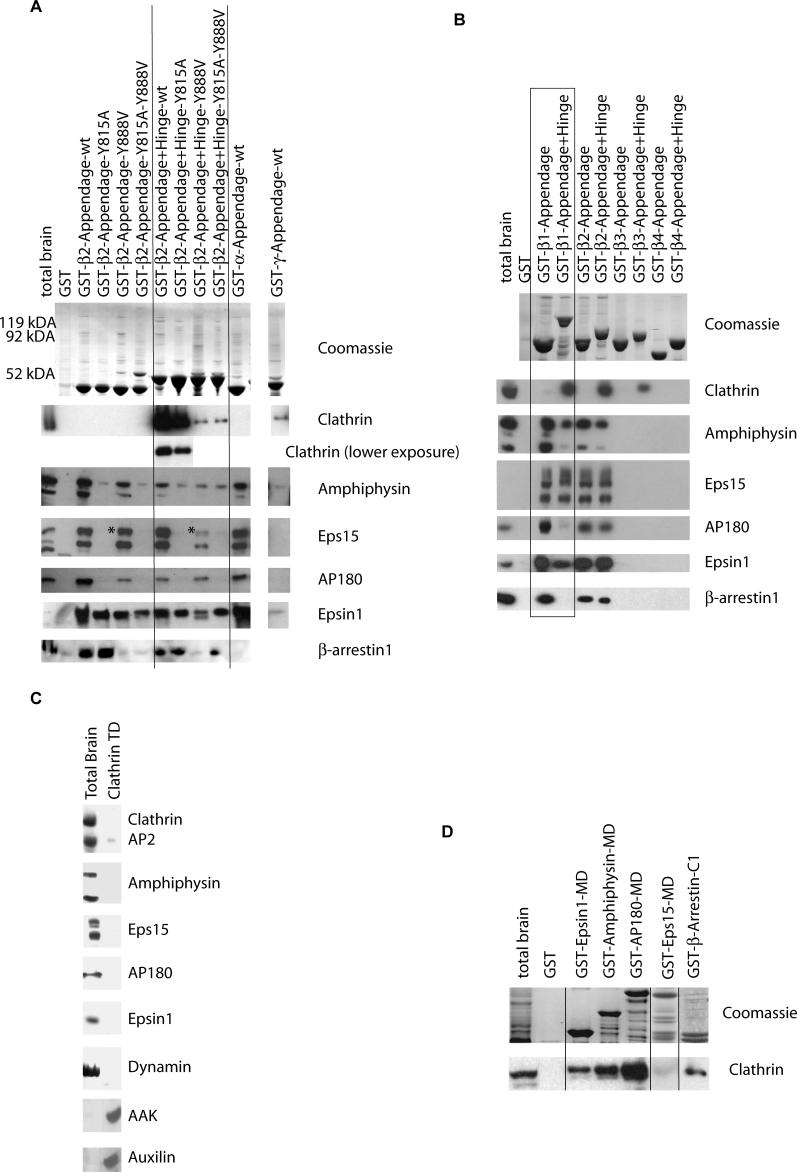
Introducing the Clathrin Hub(A) Displacement of β-appendage interactors with clathrin binding. A comparison of protein interactors with the β-appendage +/− the connecting linker to the core of the adaptor complex (the hinge domain) is made. Rat brain extract was used. The asterisks point to a reduced binding of Eps15 to the Y888V mutant only when clathrin is present. It can be noted that β-arrestin is not enriched in the pull-downs over total lysates (where 1% of the volume used for the pull-down is loaded) and given the high affinity of arrestins for the β-appendage we conclude that only a small percentage of the arrestin is in the “open” conformation necessary for β-appendage binding. Amphiphysin is also not enriched, but it has a much lower affinity for the β-appendage.(B) β1 appendage+hinge binding to clathrin results in reduced accessory protein interactions. Appendage and appendage+hinge proteins from β1 to β4 adaptins and their interactors are compared. We found no specific bands by mass spectrometry that interact with β3 and β4 in these experiments (apart from chaperones) See Figure S3 for β1–4 appendage homologies.(C) Clustered clathrin N-terminal domain interactions with accessory proteins. The GST-β-propeller domain has been bound to sepharose beads and thus we should especially detect proteins that can bind to clathrin via multiple interactions.(D) Clathrin binding of MDs from various accessory proteins except Eps15. GST-MDs on beads were incubated with rat brain extract and clathrin was detected by Western blotting.